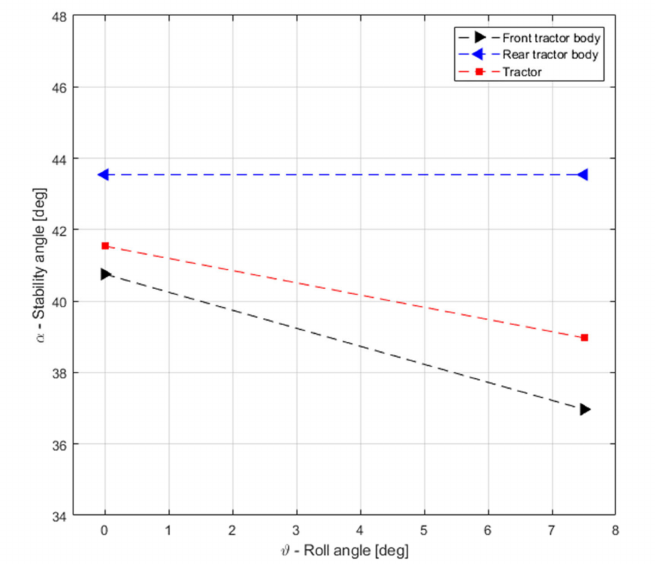
Figure 6. Tractor in the straight configuration: tractor stability angles vs. Roll angle. Front tractor body (black line), rear tractor body (blue line) and whole tractor (red